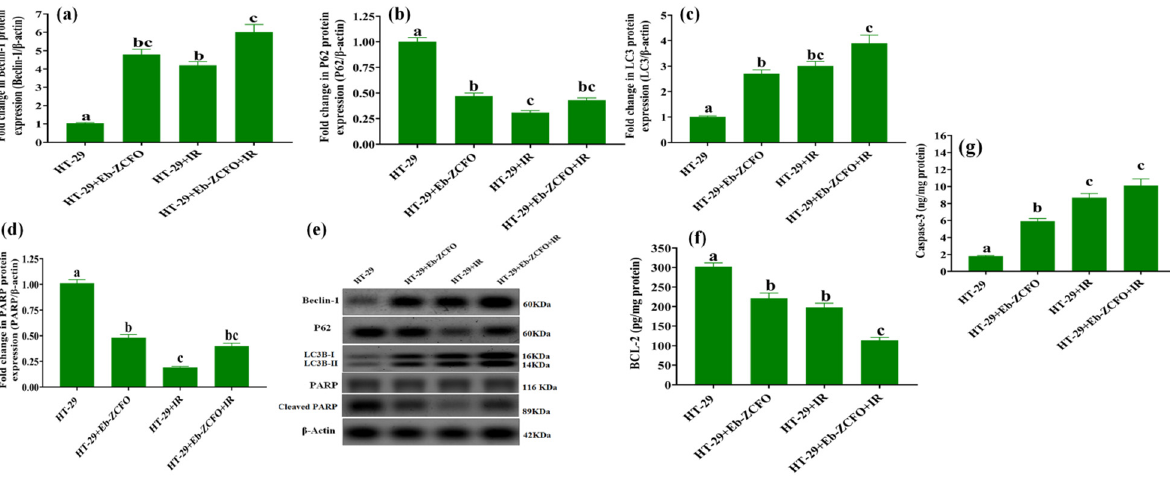
Figure 18. Autophagy and apoptosis in HT-29 cells. Represented as follows: fold change in protein expression of ( a ) Beclin-1; ( b ) P62; ( c ) LC3B-II; ( d ) cleaved PARP-1; ( e ) representative western blot analysis, SDS-PAGE of Beclin-1, P62, LC3B-II/LC3B-I, cleaved PARP-1, and β -actin; ( f ) BCL-2; and ( g ) cleavedcaspase-3 protein levels. Results are expressed as the mean and standard error of the mean (SEM) (n = 3). Columns with dissimilar letters (a, b, c…) overhead within the same histogram are significantly different, and columns with the same letters are not significantly different at p < 0.05. HT-29 group: untreated HT-29 cells served as control. HT-29 + Eb-ZCFO group: HT-29 cells treated with Ebselen (Eb) and ZnCe 0.06 Fe 1.94 O 4 nanoparticles (ZCFO). HT-29 + IR group: HT-29 cells exposed to γ -radiation. HT-29 + Eb-ZCFO + IR group: HT-29 cells treated with Eb-ZCFO and exposed to IR.